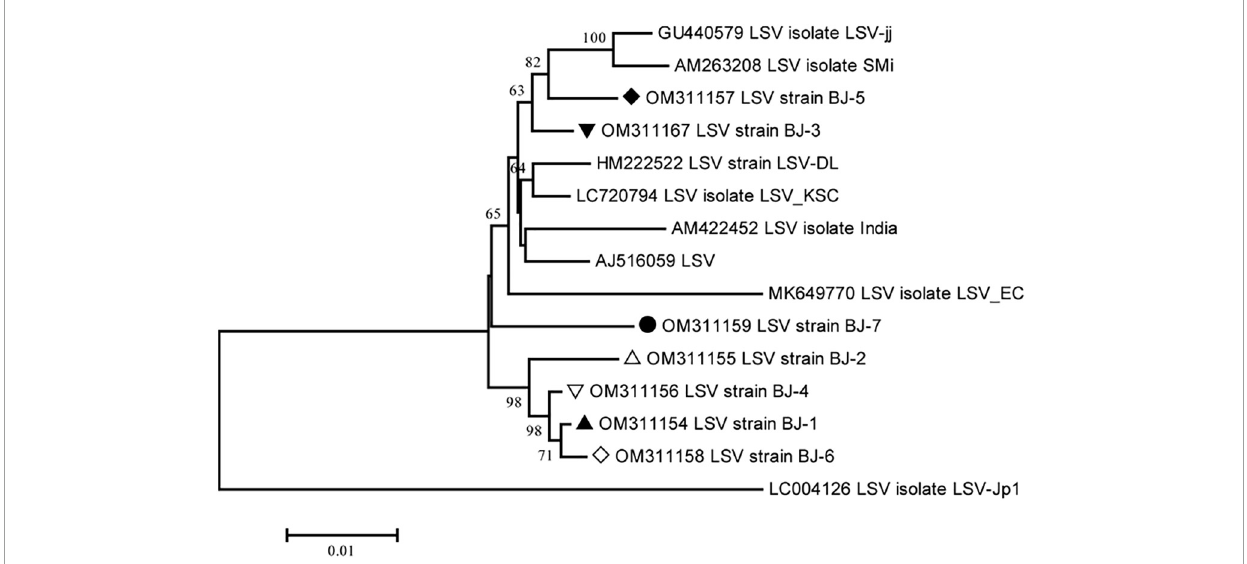
FIGURE7 Phylogenetic analysis of the lily symptomless virus (LSV) based on the replicase (refer to RdRp) amino acid sequences of all available complete genome sequences constructed with NJ method with 1,000 bootstrap replicates. Bootstrap values are given by numbers at the relevant nodes in the topology and only bootstrap values of ≥ 50% were shown. LSV BJ-1 (OM311154) was indicated with solid black triangle, LSV BJ-2 (OM311155) was indicated with triangle, LSV BJ-3 (OM311167) was indicated with inverted solid black triangle, LSV BJ-4 (OM311156) was indicated with inverted triangle, LSV BJ-5 (OM311157) was indicated with solid black rhombus, LSV BJ-6 (OM311158) was indicated with rhombus, and LSV BJ-7 (OM311159) was indicated with solid black